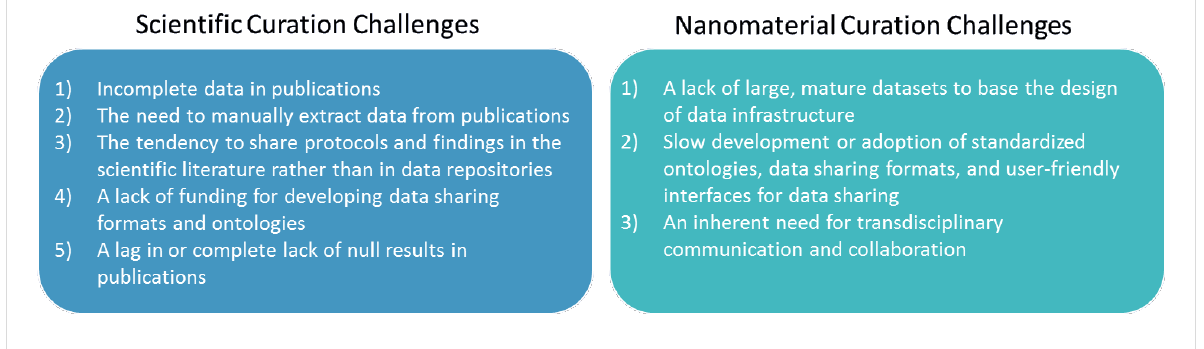
Figure 6: Scientific and nanomaterial curation challenges. Nanomaterial curation challenges expand on curation challenges inherent in general scien- tific